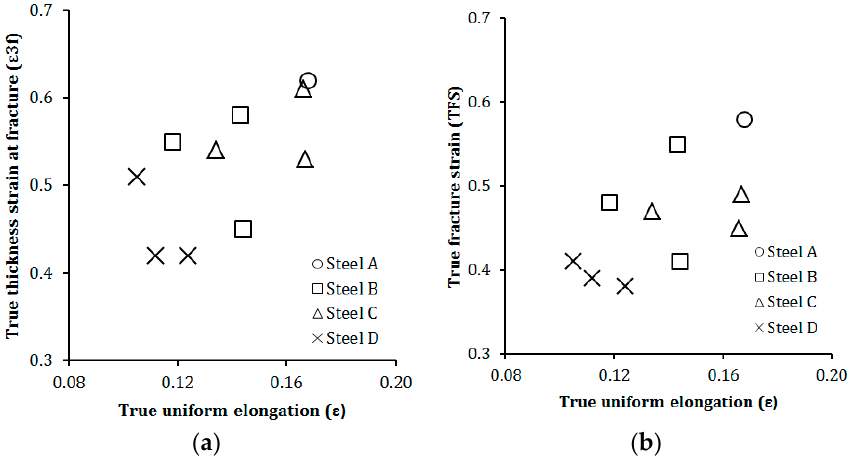
Figure 3. True thickness strain at fracture ( a ) and true fracture strain ( b ) of the investigated